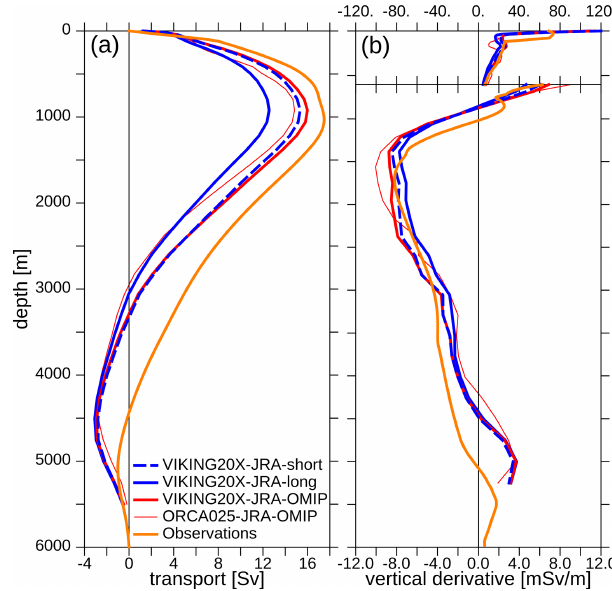
Figure 4. Profiles of the (a) AMOC (inSv) and (b) its vertical derivative (in mSvm − 1 ) at 26.5 ◦ N (note the different ranges above and below 600m depth) for experiments and RAPID observations (orange), all averaged from